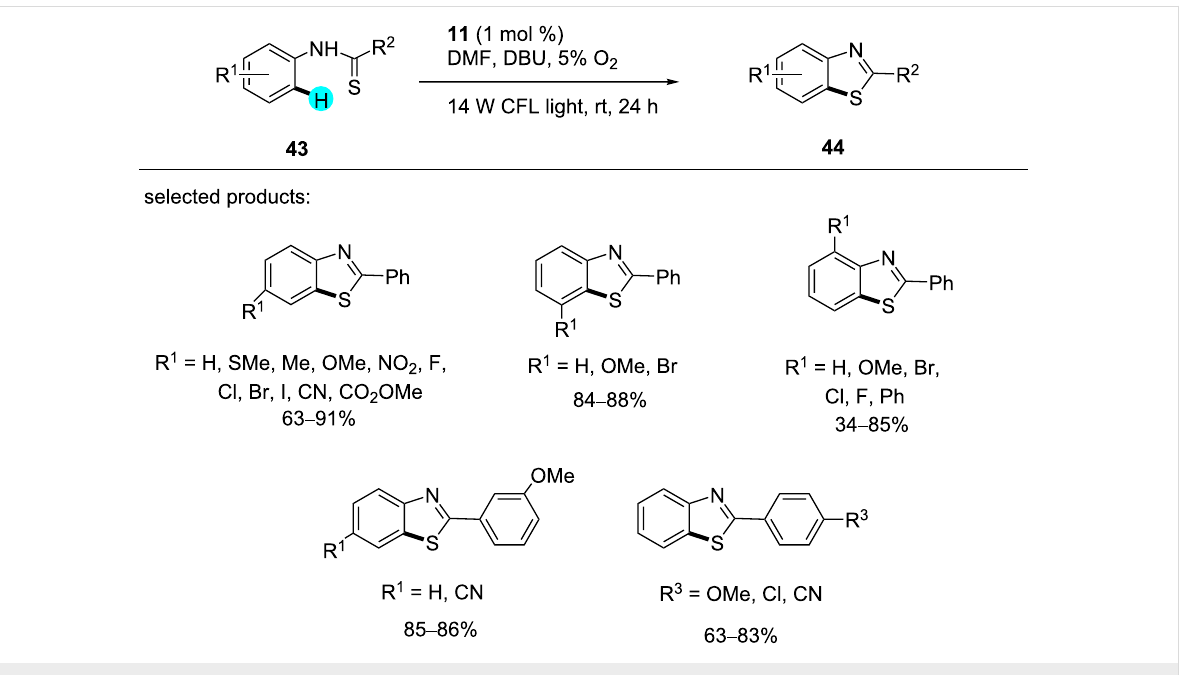
Scheme 5: Synthesis of benzothiazoles via aerobic C–H